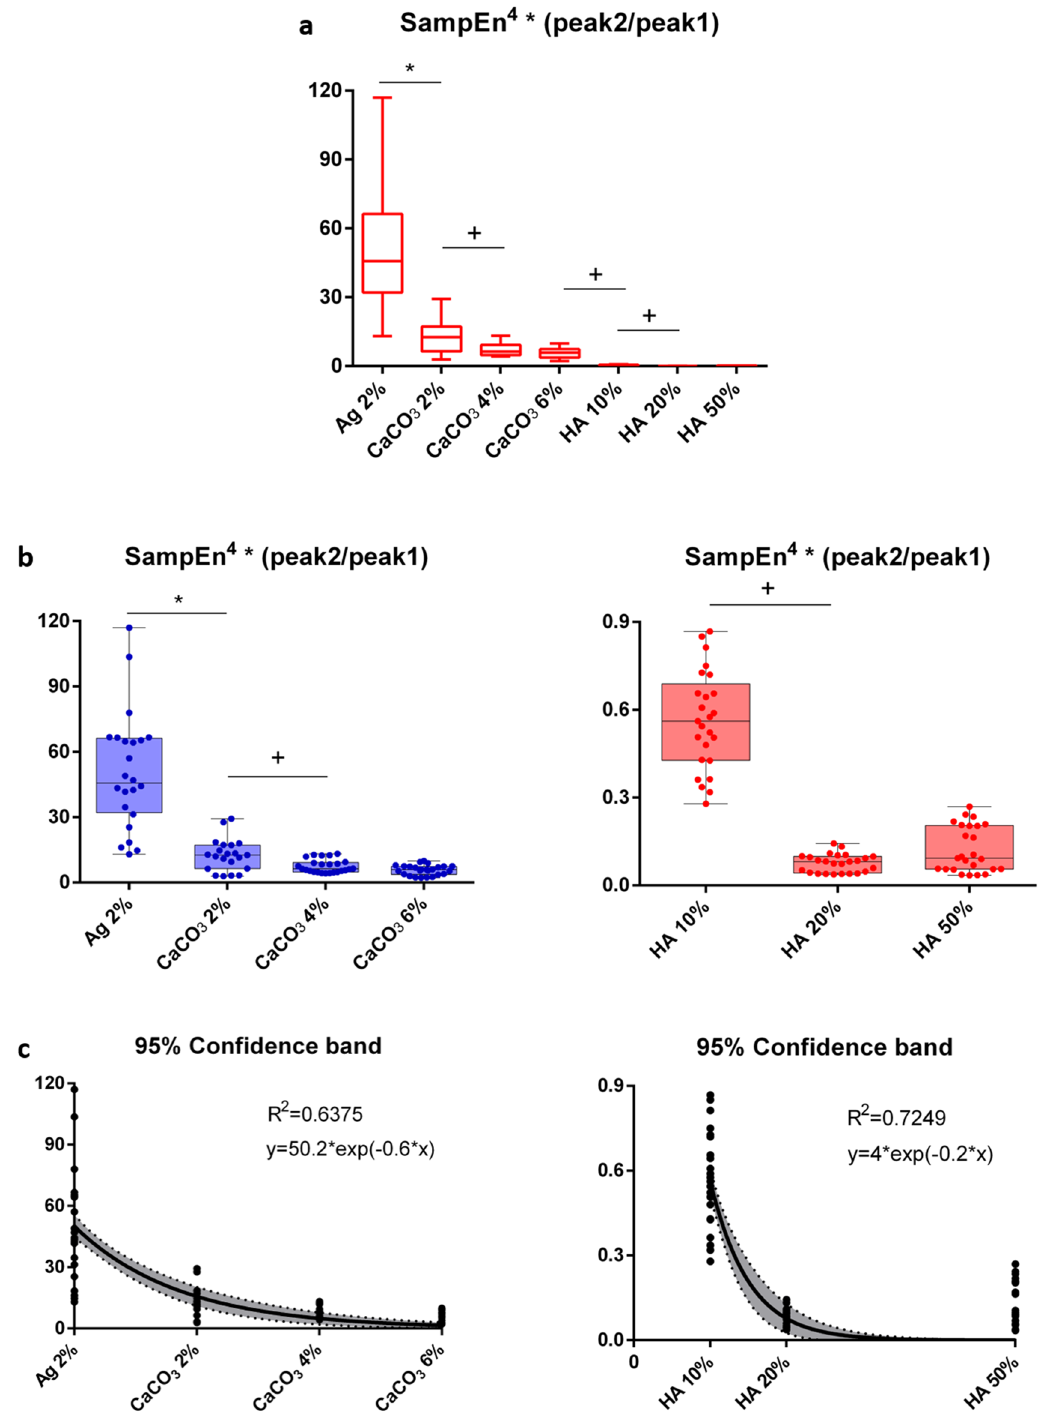
Figure 7. Boxplot and regression analysis of f(s) for samples containing different concentrations of CaCO 3 and HA particles. The panel ( a ) shows the trend associated to the model including all the previous parameters (SampEn, peak1 and peak2) for: Ag 2% (control), CaCO 3 at different concentrations (2%,4% and 6% w/v) and HA at different concentrations (10%, 20% and 50%). The statistical comparisons of the closest groups are also presented: the symbol * indicates p < 0.05 for the comparison of the groups to the control group, the symbol + indicates p < 0.5 for the comparison of the groups to each other. In panel ( b ), the trend of the combined parameter is provided, separating CaCO 3 (left image) and HA (right image). Since agarose values were much higher than HA ones (at least a difference of one order of magnitude), they were excluded from HA representation. Finally, panel ( c ) shows the regression analysis for both CaCO 3 (left) and HA (right) at different